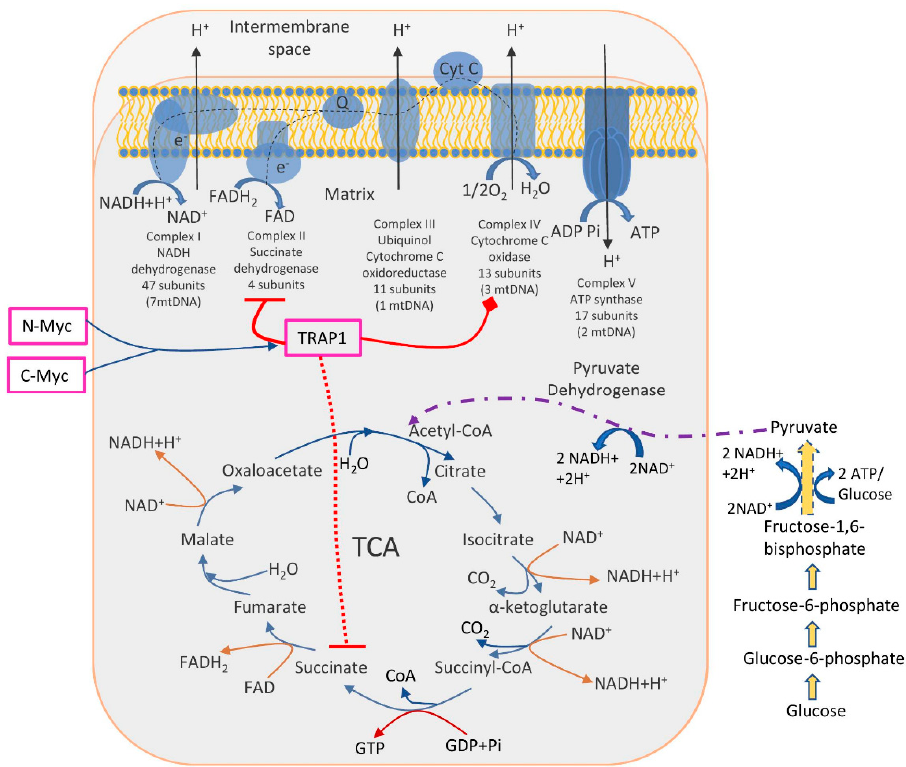
Figure 1. The role of TRAP1 in the regulation of metabolic switch between glycolysis and OXPHOS. TRAP1 was shown to inhibit OXPHOS (complexes II and IV, enzymes succinate dehydrogenase and cytochrome oxidase, respectively). Simultaneously, succinate dehydrogenase is a part of the TCA cycle; thus, its inhibition interrupts normal TCA functioning, further enhancing glucose utilization. Two oncogenic proteins N-Myc and C-Myc control TRAP1 expression and, subsequently, energy production in cancer cells.